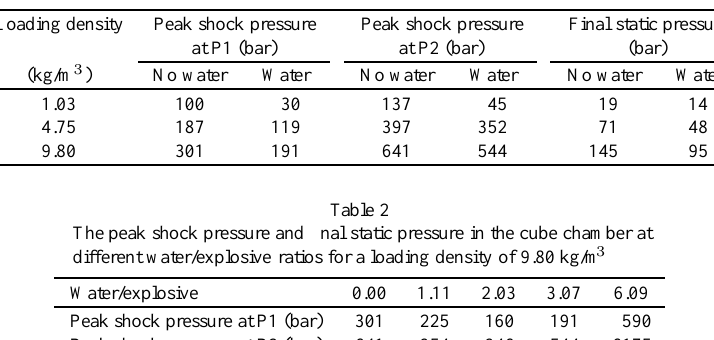
densities. The water/explosive ratio is 3.07 for all the water cases